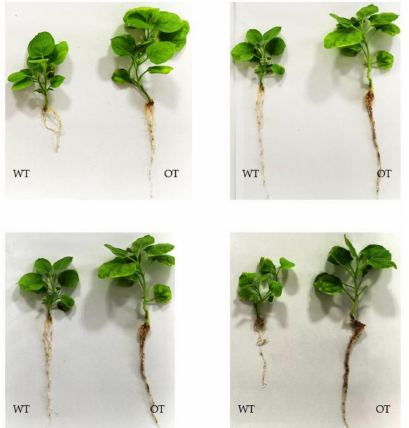
Figure 8. Effects of salt stress on the phenotypes of wild-type and transgenic tobacco.